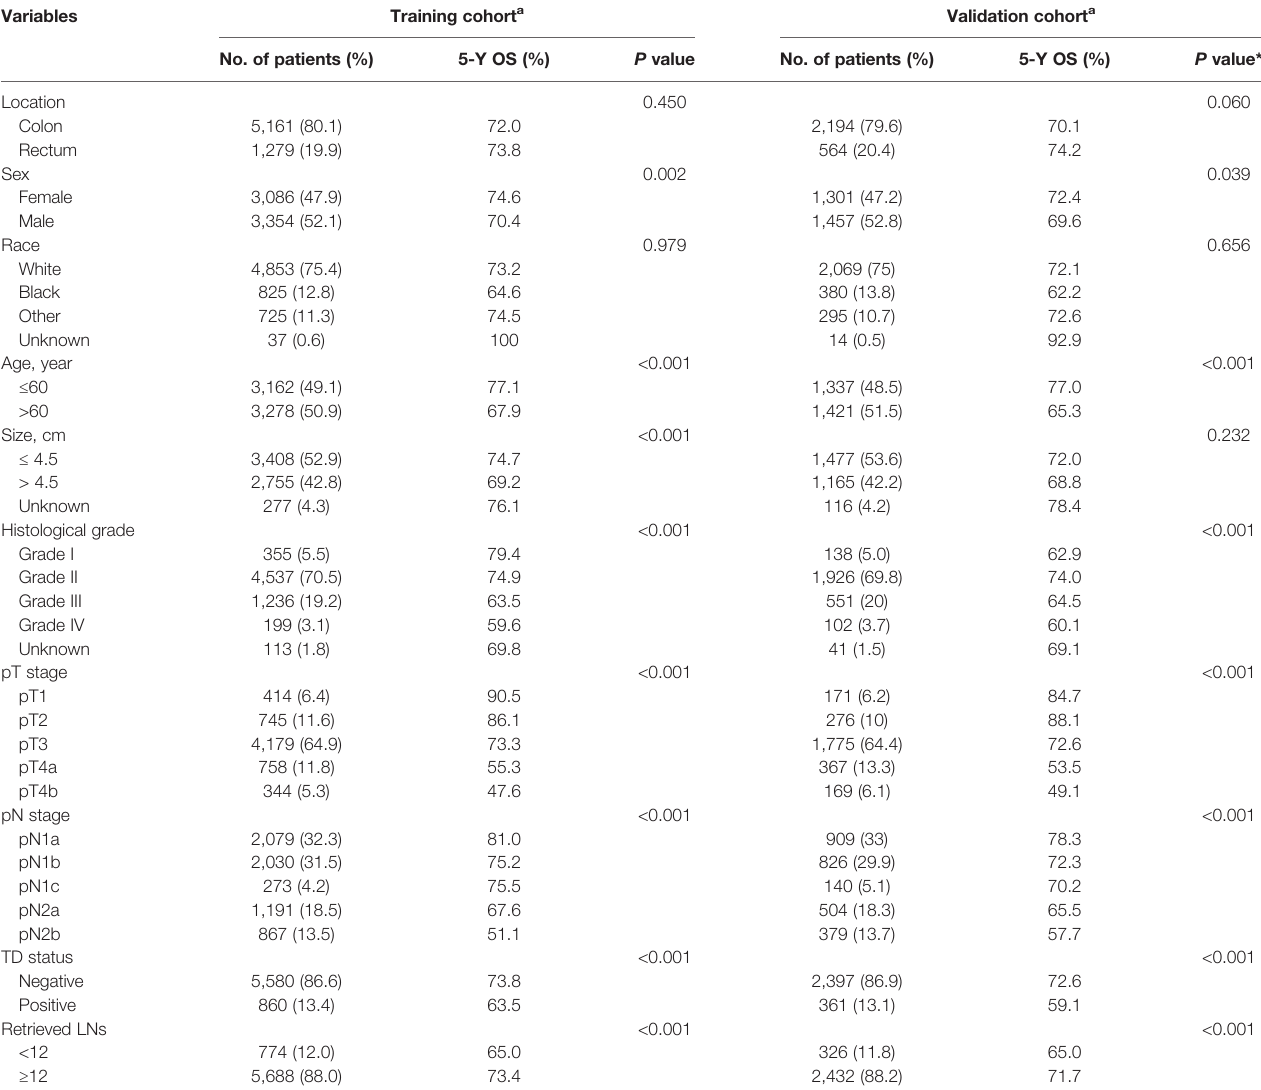
TABLE 1 | Baseline clinicopathologic characteristics and univariate analysis of training and validation cohorts.